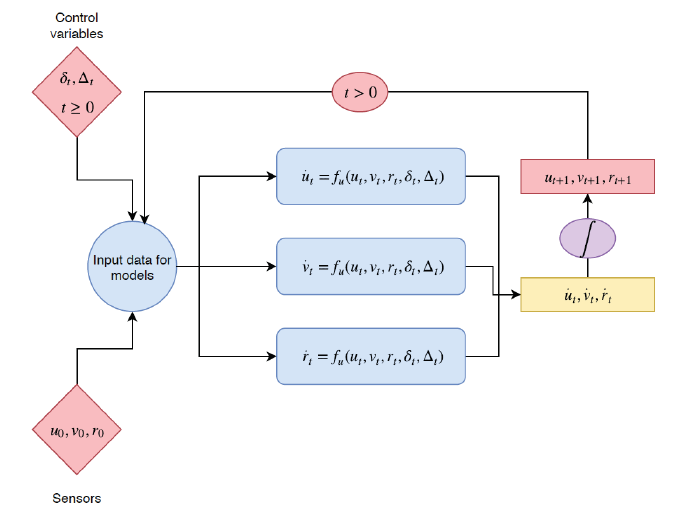
Figure 4. Freerun simulation diagram. At time t 0 , the input variables are given from the sensors, and for t > 0 the speed inputs for t + 1 are the predicted values in t